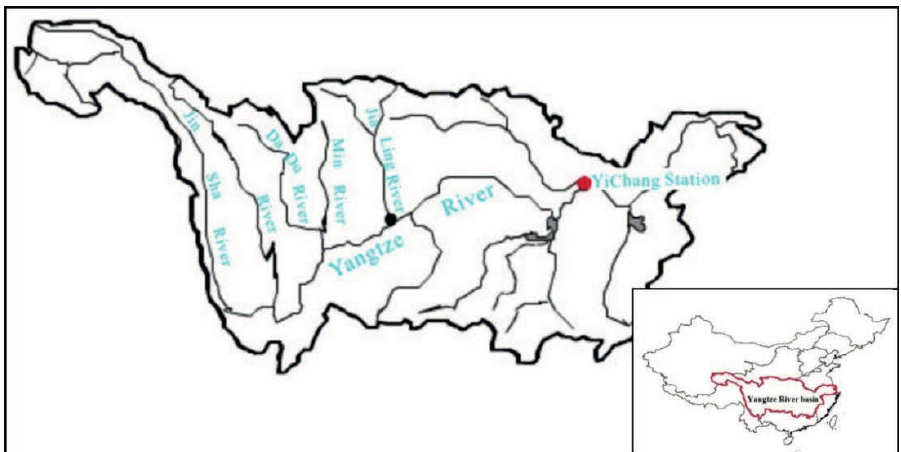
Fig. 2 The location of Yichang station on the Yangtze River,